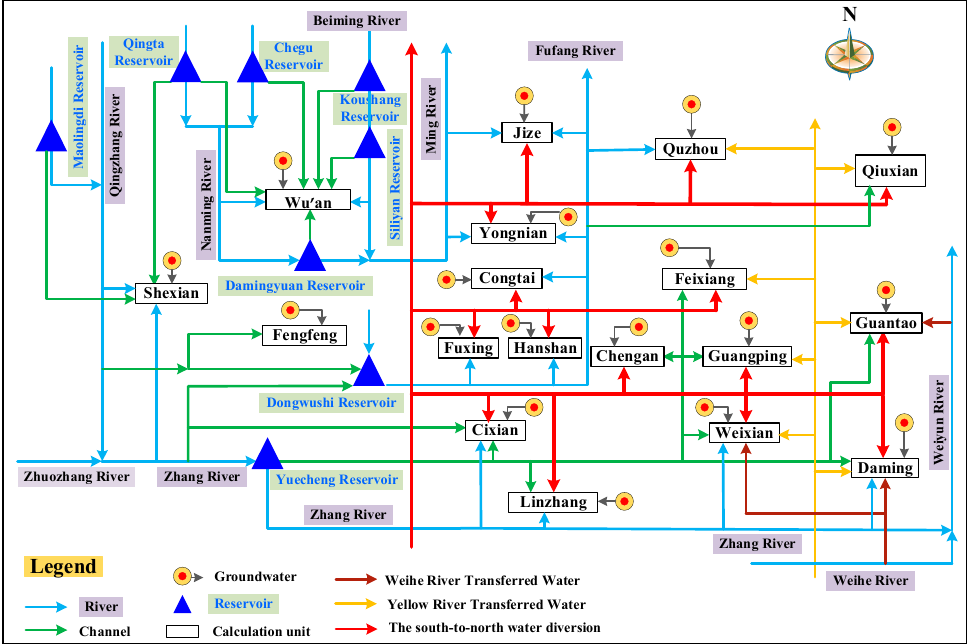
priority of water supply from the reservoir to different industries, where number 1 indicates the highest priority and number 5 indicates the least. Figure 2. Topological diagram of water supply and consumption in the GWAS model.